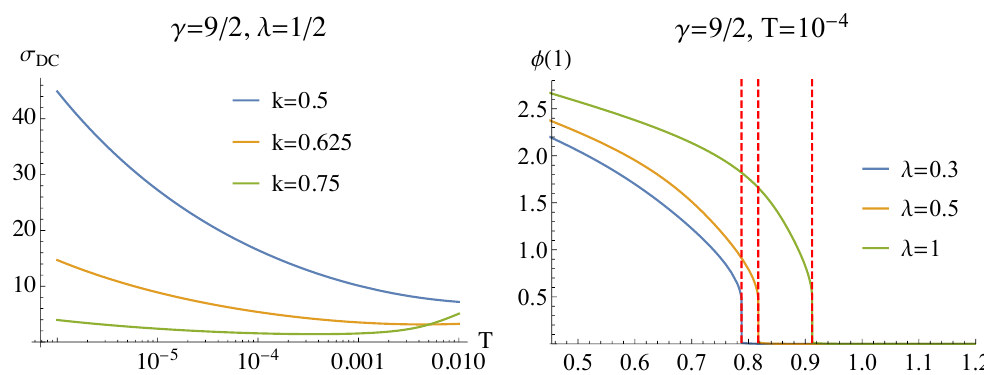
Figure 2 . Left plot: the DC conductivity as the function of T for γ = 9 / 2 , λ = 1 / 2 at different values of k . Right plot: the value of the dilaton field φ at the horizon. The red dashed lines are the positions of QCPs for specific λ